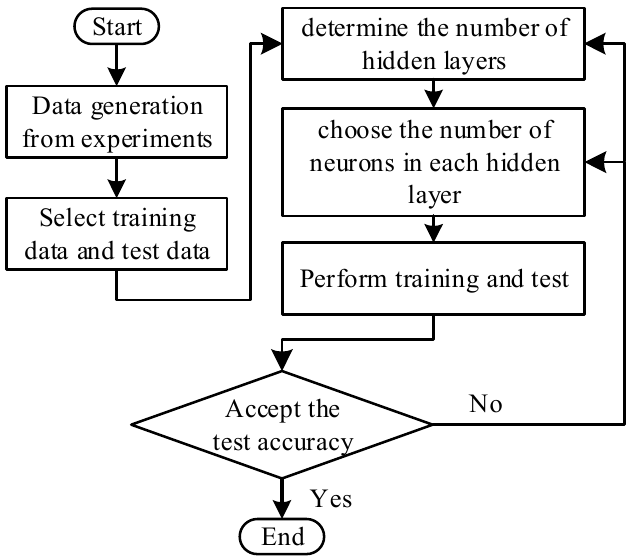
Figure 7. Flowchart of the steps for ANN training and testing.